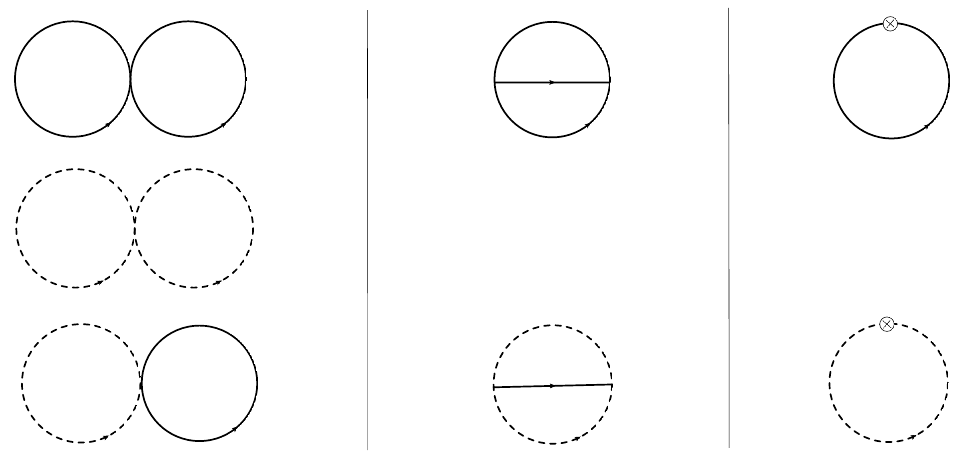
Figure 2 . Feynman diagrams contributing to the two-loop corrections to the entanglement entropy in (4.4). The solid lines denote the massive mode σ while the dashed lines represent the Goldstone bosons π i . The left column depicts the quartic interaction between σ ’s and π i ’s. The middle column is the two-loops arising from the cubic interactions, while the right one represent the counter terms’ effects to cancel the divergence due to the diagrams in the left and central